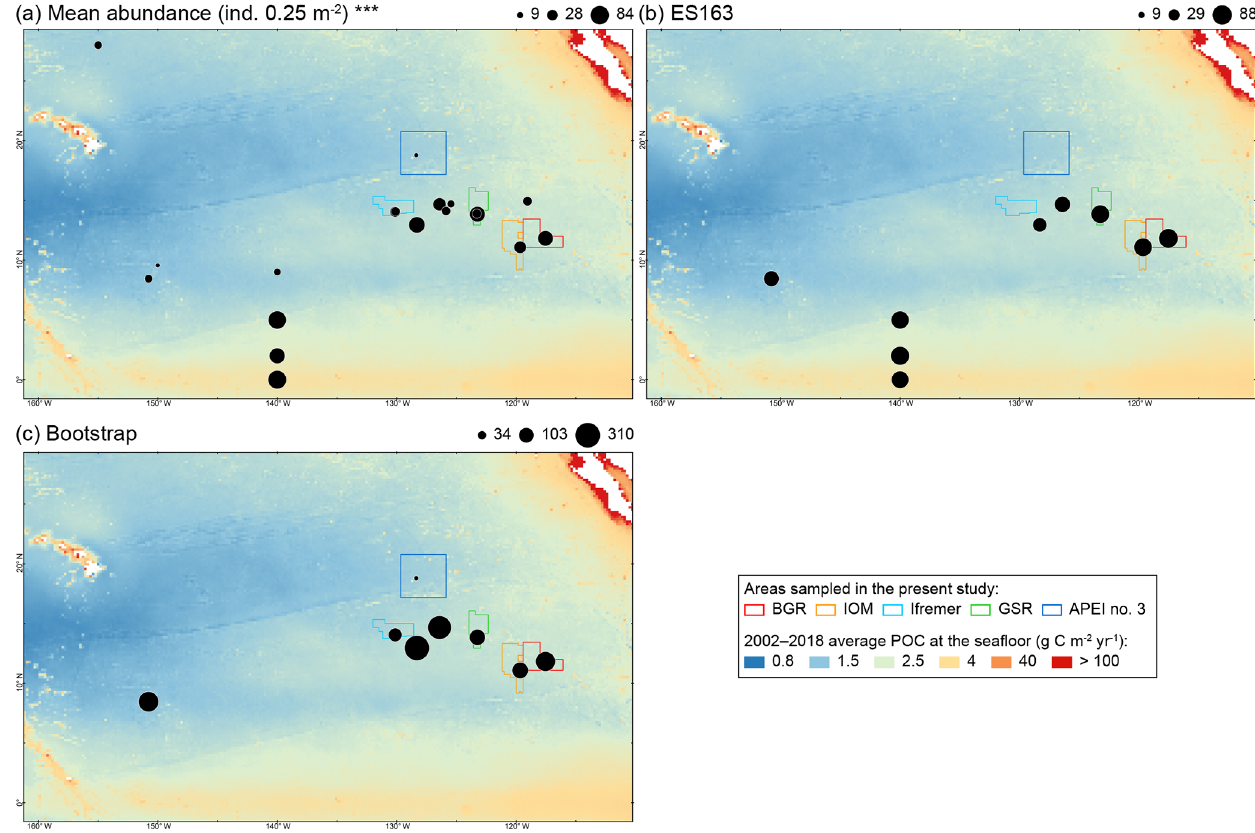
Figure 4. Plot of mean abundance (a) and diversity estimators, ES163 (b) and bootstrap (c) , from previous studies and the present study (Ta- ble 2) in relation to the 2002–2018 average particulate organic carbon (POC) flux at the seafloor along the CCFZ (background). ∗∗∗ indicates significant ( p< 0 . 001) Spearman